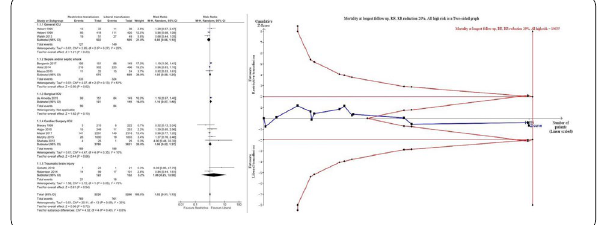
Figure 1. Forest plot analysis and Trial Sequential Analysis on mortal- ity at longest follow-up in ICU patients randomized to restrictive